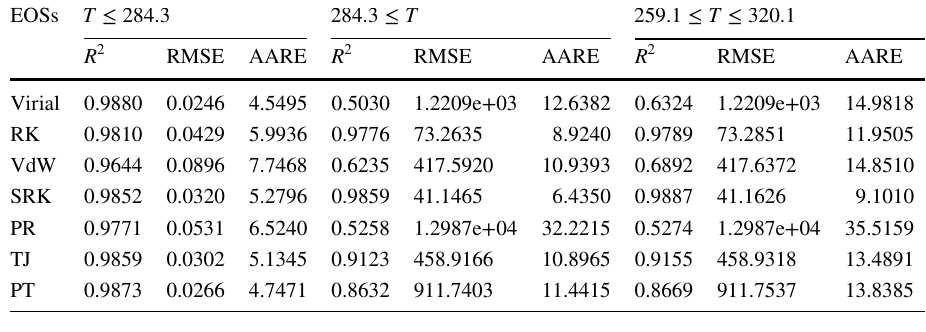
Fig. 4 Comparison between dif- ferent EOSs used in VdW-P for 259.1 ≤ T ≤ 284.3